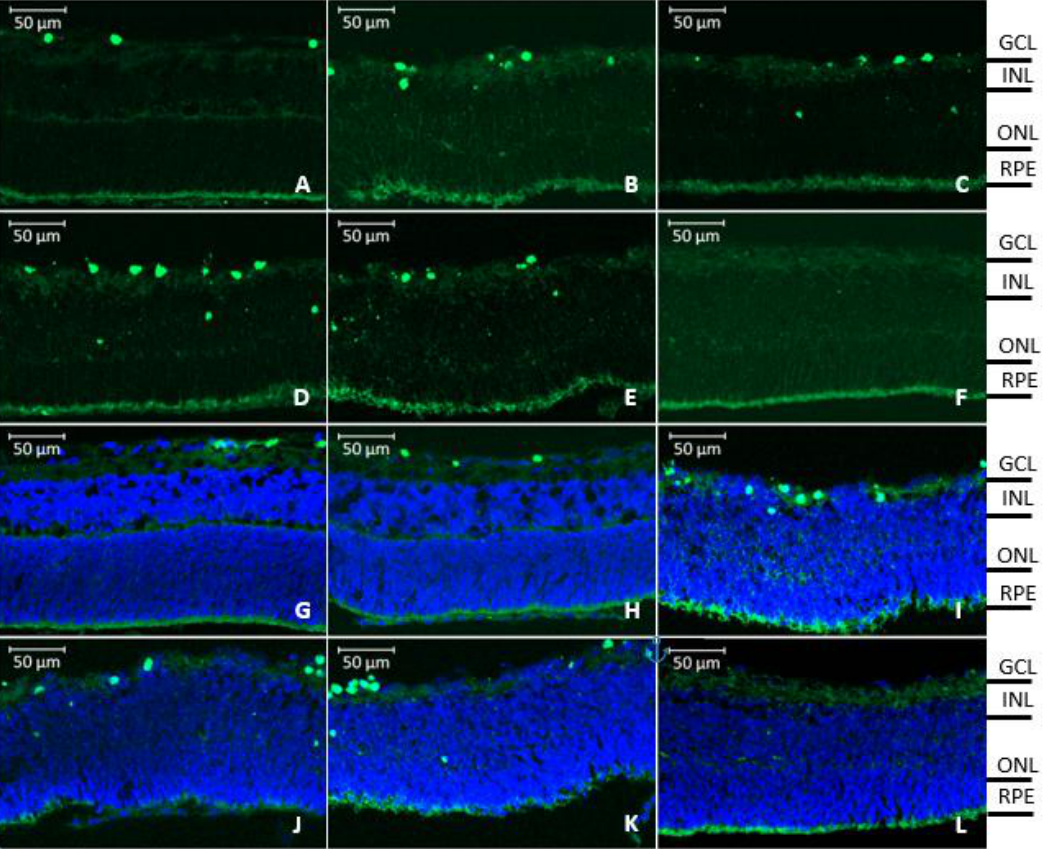
Figure 13. rhCNTF penetration in rat retinal explants as visualized without ( A – F ) and with DAPI counterstaining ( G – L ). Alexa Fluor ™ 488 labeled rhCNTF (green) penetrates and distributes in the retina after apical administration, with rhCNTF-positive cells observed in the neural retina in layers ranging from the GCL to the INL ( A – E , G – K ). No rhCNTF penetration is seen with basolaterally applied protein ( F , L ). GCL, ganglion cell layer; INL, inner nuclear layer; ONL, outer nuclear layer; RPE, retinal pigment epithelium.